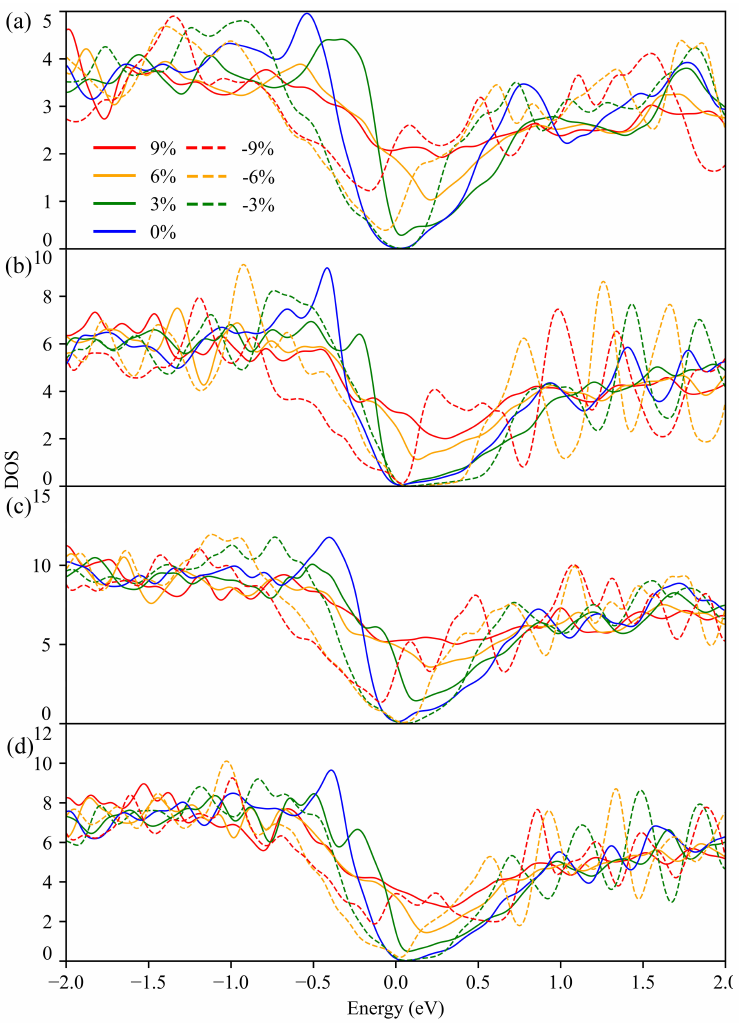
Figure 4. DOS of Bi 2 Te 3 ( a ), PbBi 2 Te 4 ( b ), PbBi 4 Te 7 ( c ) and Pb 2 Bi 2 Te 5 ( d ) under strains calculated with the PBE